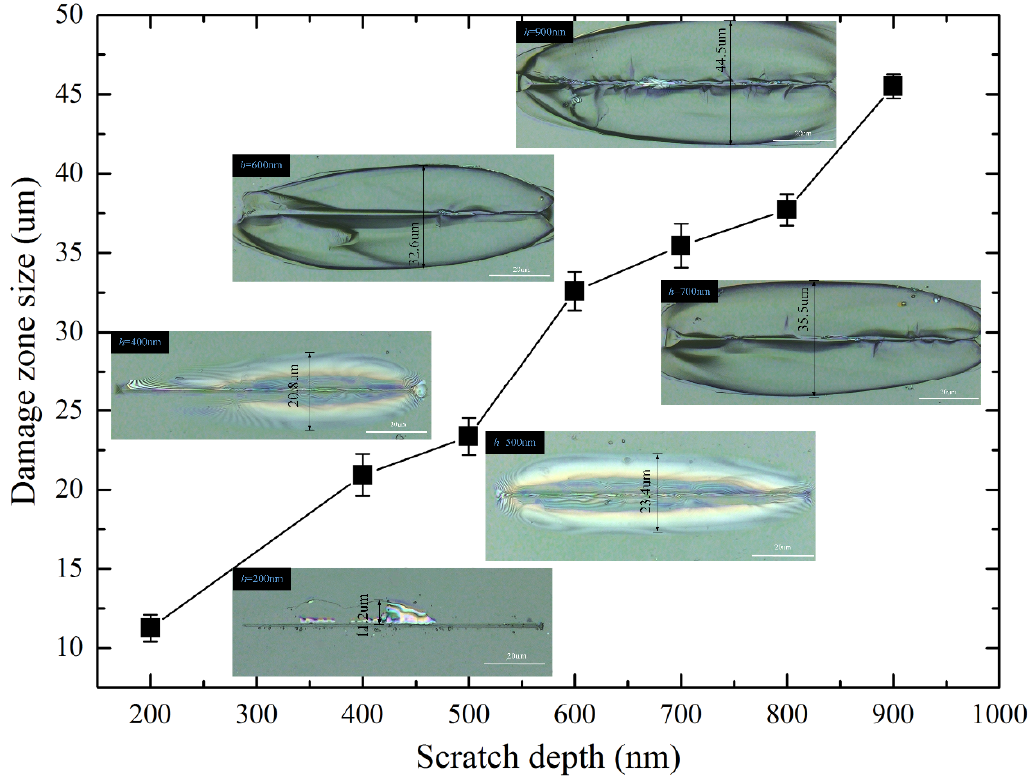
Figure 6. Resulting damage zone size due to lateral crack propagation versus scratch depth (imbedded images are optical micrographs of the scratching grooves in face-forward scratching under different scratch depths).